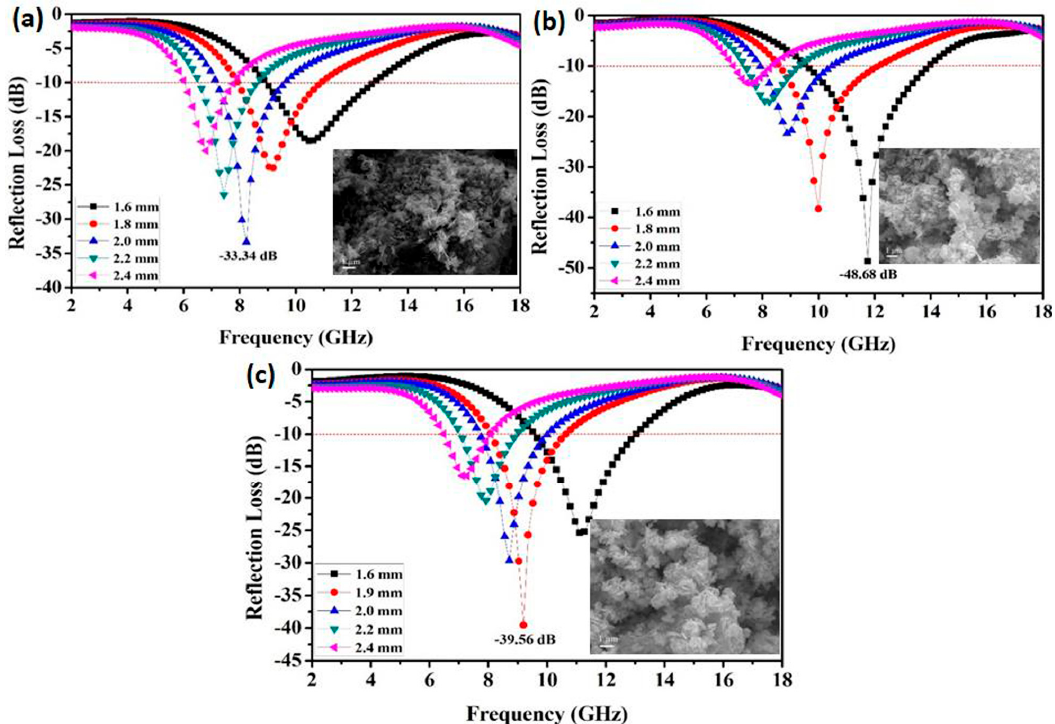
Figure 8. Reflection loss (RL) value and microstructure of FeCo/ZnO composite at different temperatures. ( a ) 120 °C; ( b ) 180 °C; ( c ) 200 °C